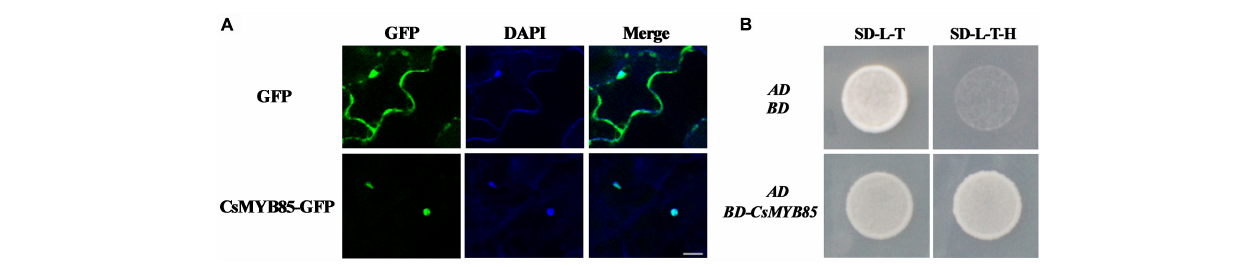
FIGURE 3 | Subcellular localization and transcriptional activation of CsMYB85. (A) Subcellular localization of CsMYB85 in tobacco leaf cells. 35S:GFP was localized in both the nucleus and cytoplasm of tobacco leaf cells. In contrast, CsMYB330:GFP was observed only in the nucleus. 4’,6-Diamidino-2-phenylindole (DAPI) signals were localized only in the nucleus. Merged images show GFP and DAPI colocalization. Bar = 20 µ m. (B) Transcriptional activation of CsMYB85 in yeast cells. The full-length coding sequence of CsMYB85 was inserted into the pGBKT7 (BD) vector. The pGADT7 (AD) vector and either BD-CsMYB85 or BD were transformed into cells of the Y2HGold yeast strain. Yeast cells containing AD and BD vectors were used as negative controls. The yeast was grown on SD media lacking –Leu/–Trp (–L/–T) or –Leu/–Trp/–His (–L/–T/–H) for 3 days at 30 ◦ C. Results were obtained from three independent transformation experiments.